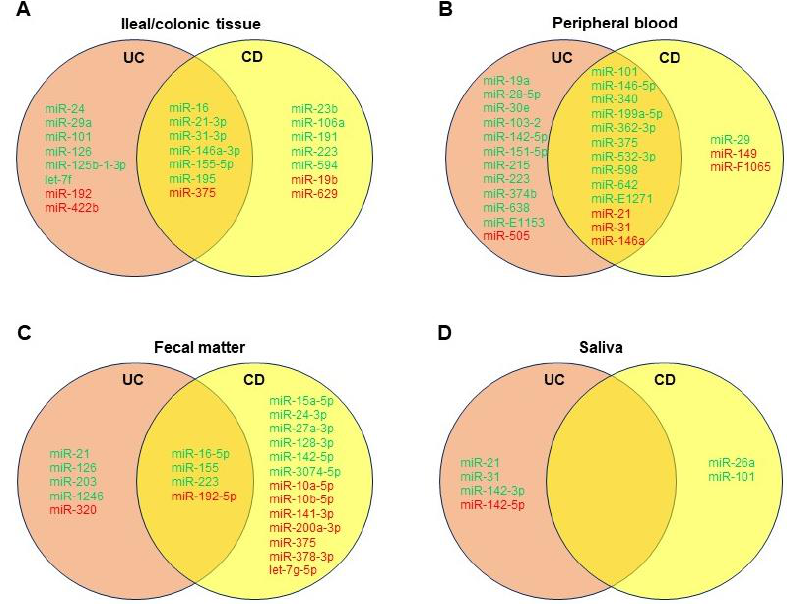
Figure 4. Venn diagrams showing significantly dysregulated miRNAs in ileal/colonic tissue ( A ), peripheral blood ( B ), fecal matter ( C ), and saliva ( D ) of patients with ulcerative colitis (UC) or Crohn’s disease (CD). Green denotes upregulated miRNAs, and red denotes downregulated miRNAs compared to healthy controls.